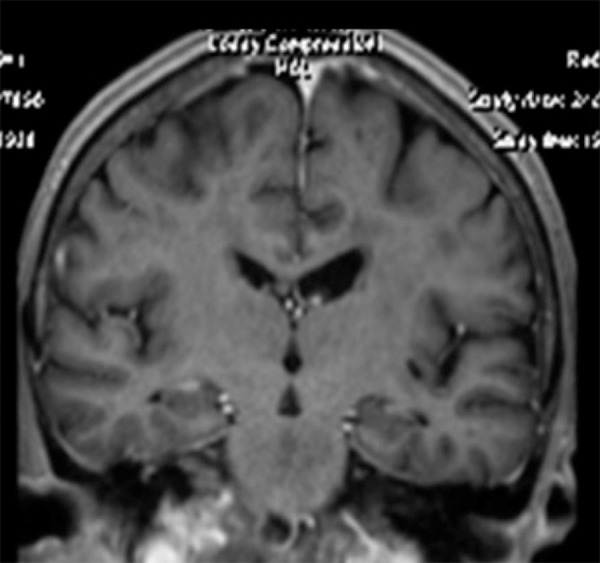
Coronal MRI presenting mesial hippocampal preservation.